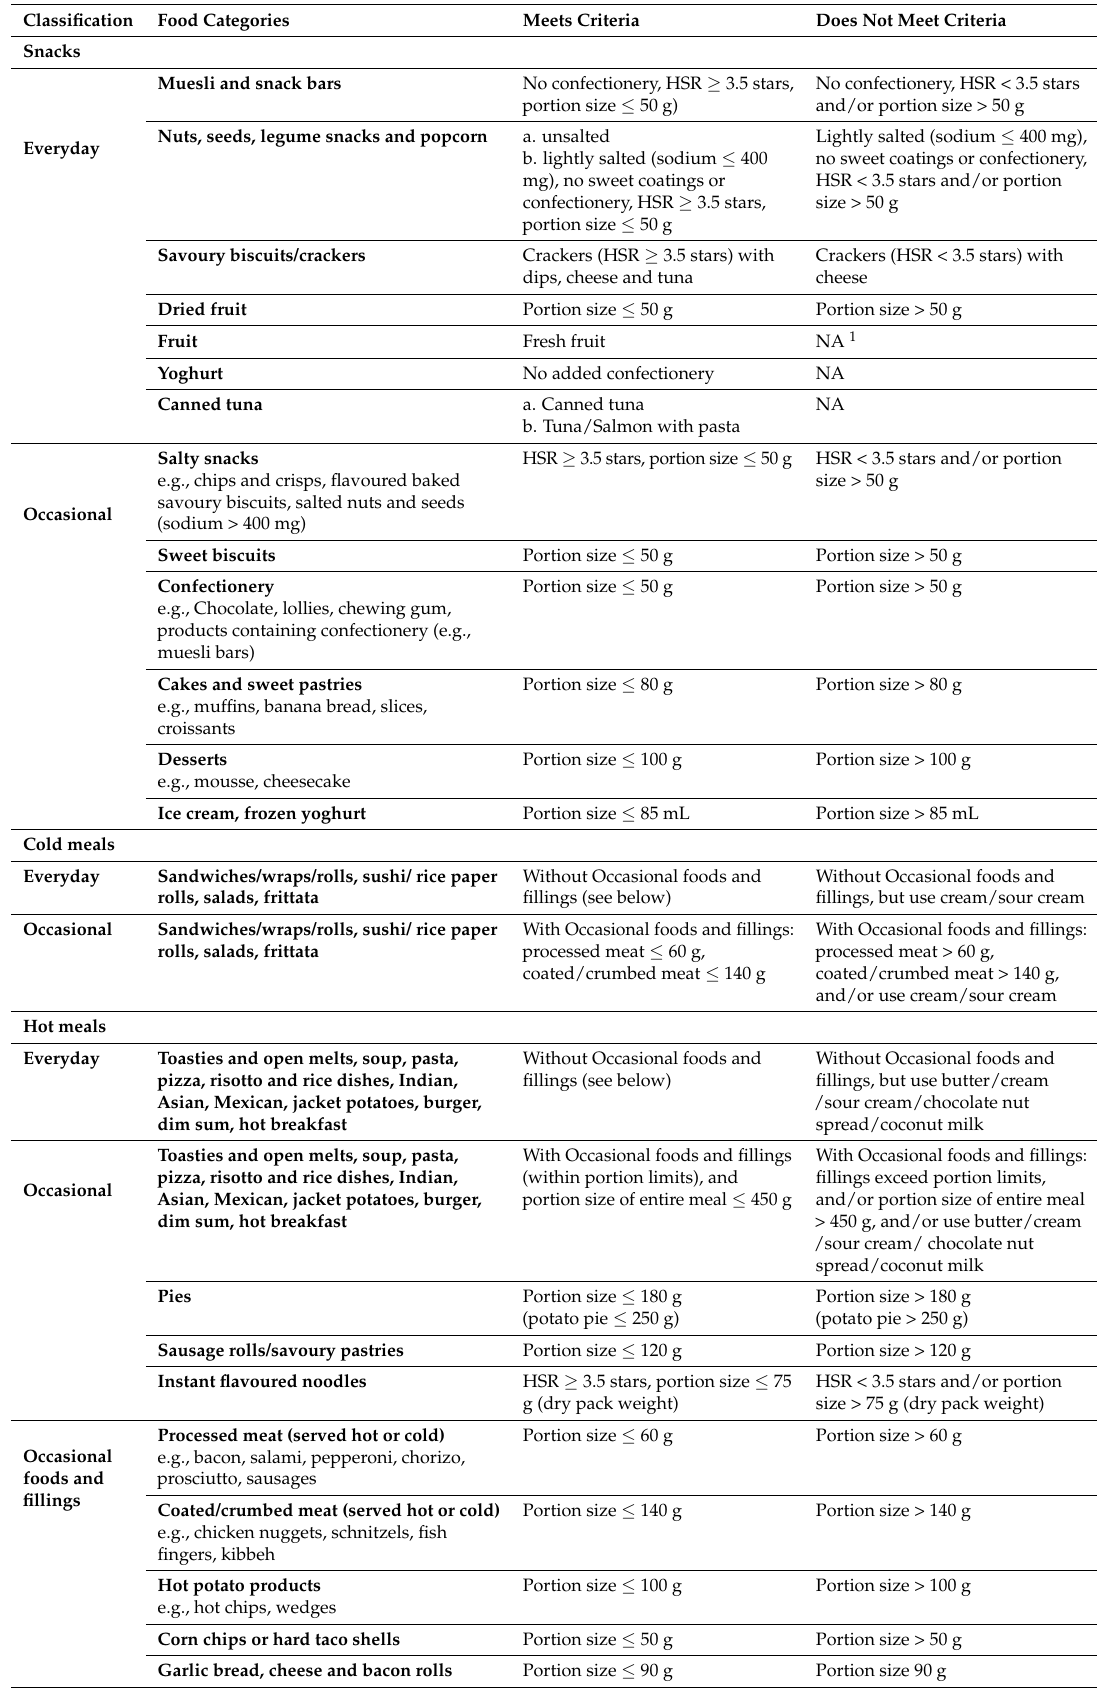
Table 1. Foods and drinks classification